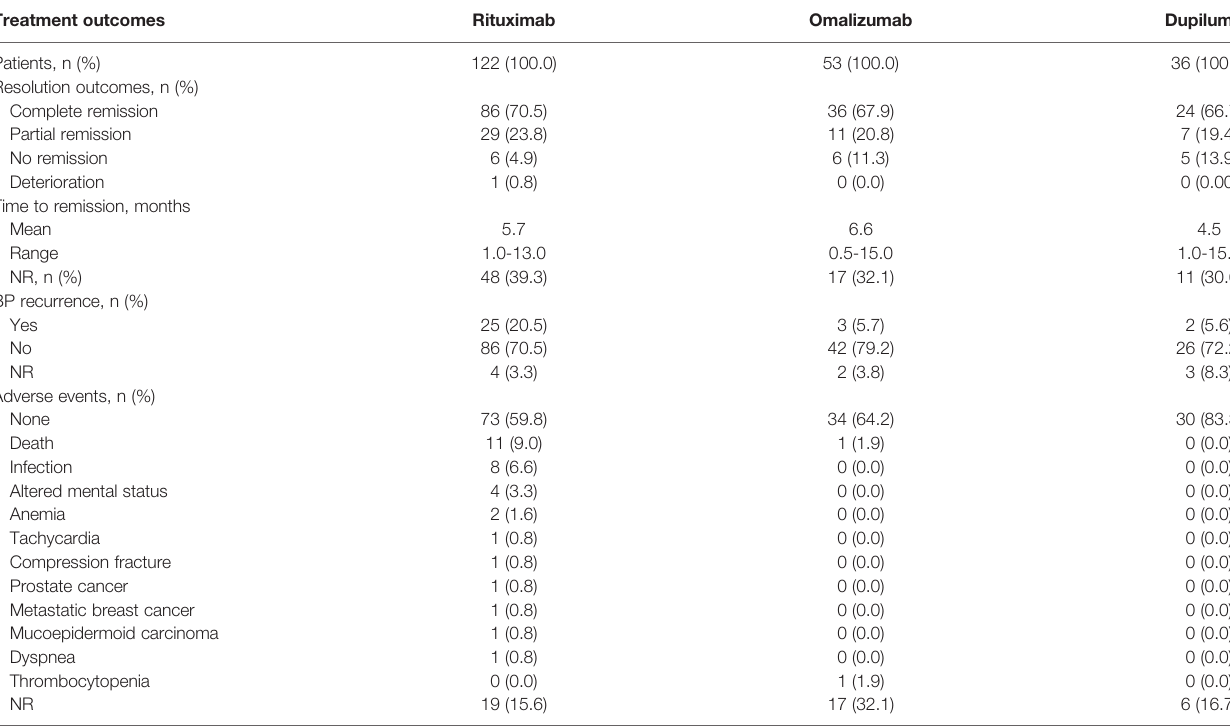
TABLE 2 | Summary of rituximab, omalizumab, and dupilumab treatment outcomes in patients with BP. Treatment